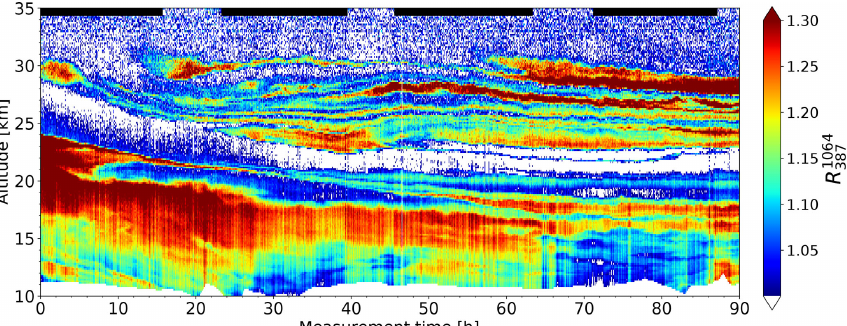
Figure 3. Stratospheric aerosol backscatter ratio ( R 1064 ) for a measurement starting at 15:30UT on 18 February 2018. The time resolution 387 is 5min, and the altitude resolution is 150m. Black bars at the top indicate nighttime configuration. At the bottom end of about 11km the data at altitudes below the tropopause are masked (white).